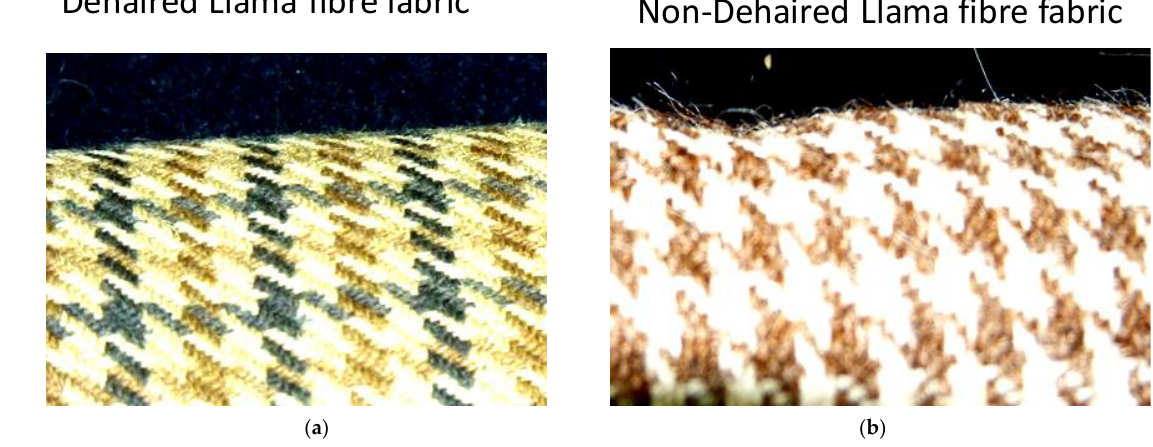
Figure 4. The two fabric samples used in the panellist test. ( a ) Dehaired llama fibre fabric; ( b ) Non-dehaired llama fibre fabric. It is clear that there is a positive bias of coarse fibres on the hairy surface of the yarn to the whole yarn, which may explain the favourable effect of dehairing on the prickle factor of llama and alpaca fibres (>5.9%). Also, in dehaired fibres, a significant difference in prickle factor is perceived by the panellist when the difference between the hairy sur- face and the whole yarn is under this value. A strong relationship exists between the amount of protruding fibres and the stiff- ness of the fibres. The stiffness is largely determined by the diameter of the fibre; there- fore, the diameter of the fibres in the cross section was estimated to obtain ellipticity, the Br of the fibres in the longitudinal direction, and the Bl of a fibre that protrudes 2 mm above the fabric. The results are shown in Table 4 in relation to the degree of fineness, the type of wave, and the type of medulla of the fibre. The types of fibre, defined by fineness, type of wave, and medulla, are significantly different for El, Br, and Bl; similar results were obtained with fibre diameter, curvature, number of scales, height of scale, and so on [1]. Some important correlations were obtained between MFD and Br (0.84) and Bl (0.82), similar to cotton fibre work [9]. Interesting correlations were also obtained with the degree of fibre curvature (Br: −0 .71 and Bl: −0 .36). The ellipticity of the fibre also ex- plains the bending rigidity (r = 0.50). Table 4. The cross fibre diameter (MFDc), ellipticity (El), bending rigidity (Br), and buckling load (Bl) of fibres in relation to fineness, type of wave, and type of medulla. Fineness MFDc